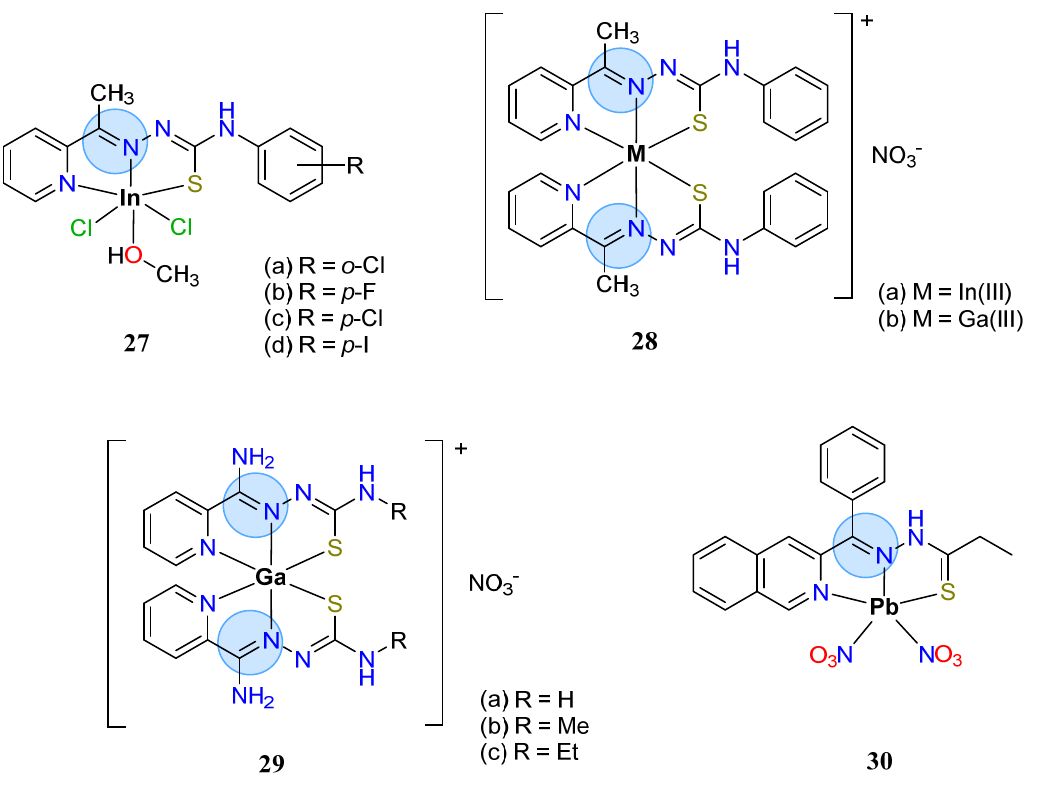
Figure 13. Indium(III), gallium(III), and lead(II) complexes with NNS thiosemicarbazones ligands studied in antimicrobial activity. studied in antimicrobial